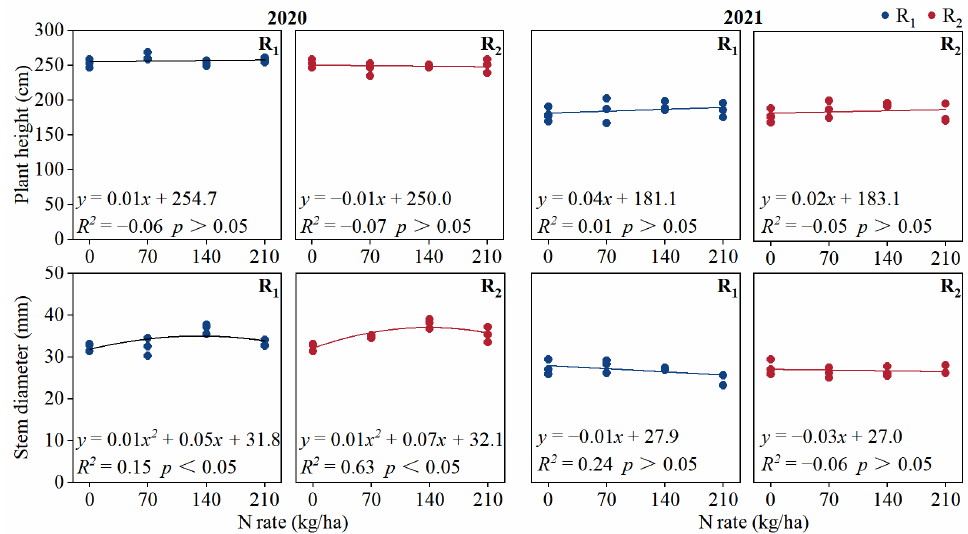
Figure 3. Plant height and stem diameter under different treatments in 2020 and 2021.